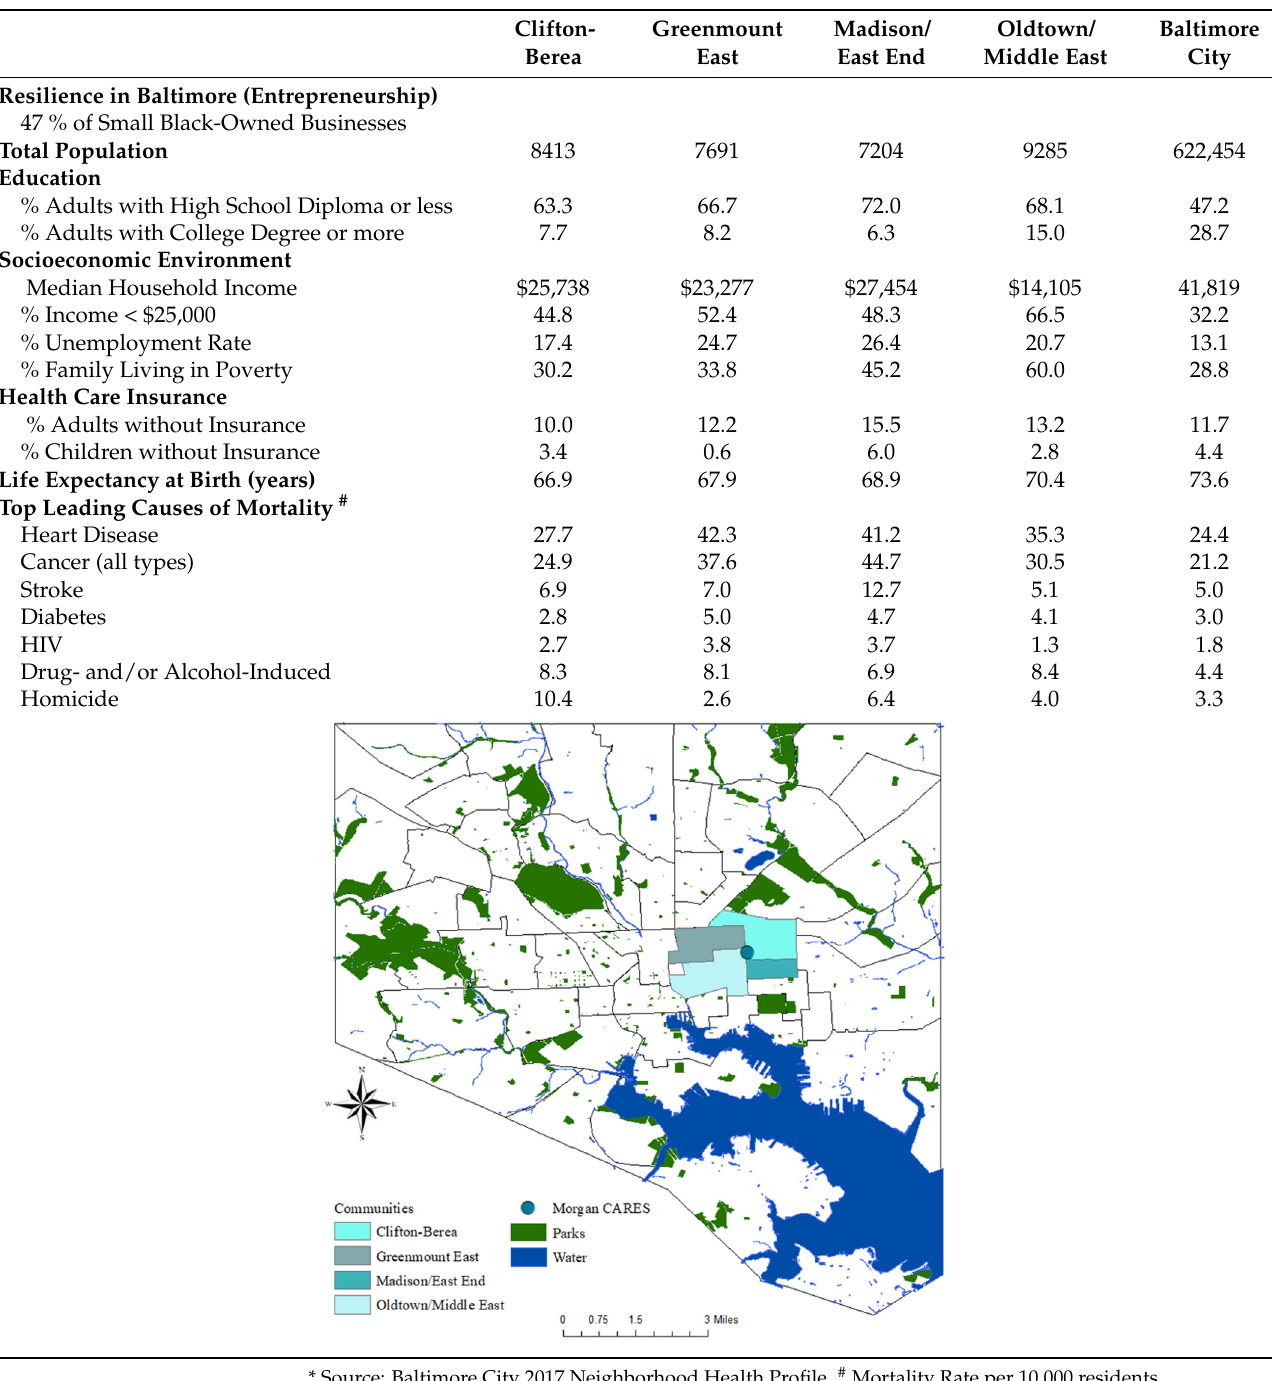
Table 1. Neighborhood Composition and Social Determinants of Health in East Baltimore *. Clifton-